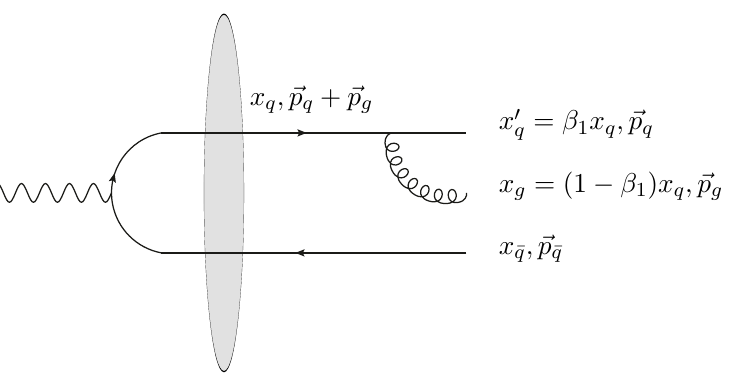
Figure 9 . Kinematics for the q − g splitting contribution. We indicate the longitudinal fraction of momentum carried by the partons as well as their transverse